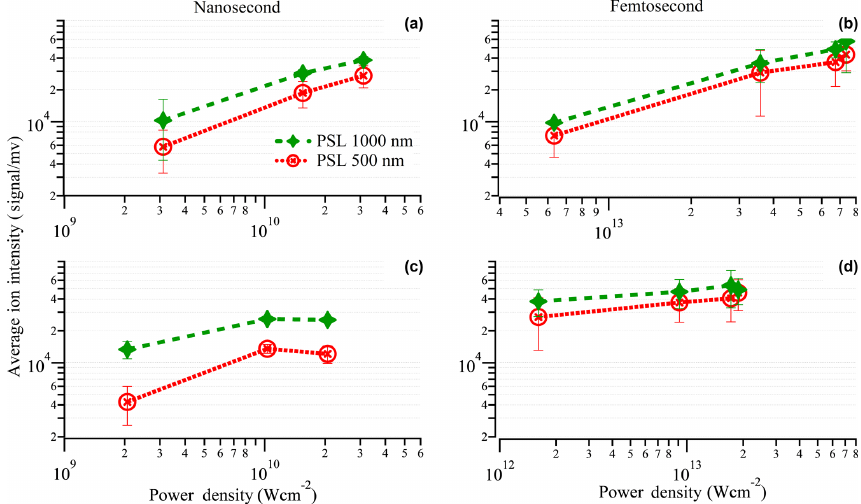
Figure 10. Variation in average total ion intensity with respect to the size of PSL particles. The total ion intensities were averaged for 10 representative spectra of each particle type. Particle diameters are 500nm for red circles, and 1000nm for green triangles). (a, b) At the focus position F2 and (c, d) at the focus position